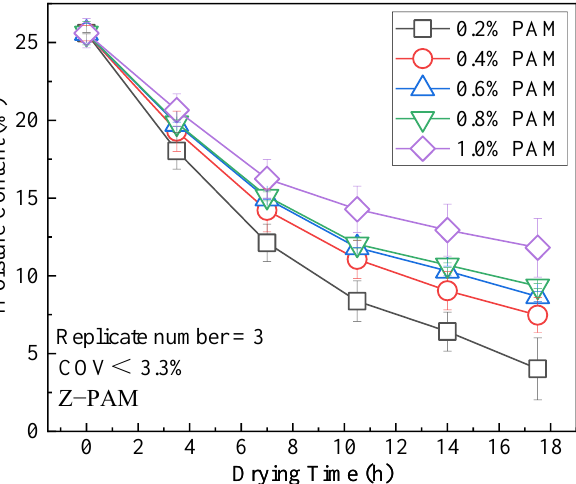
Figure 4. The moisture content of the compacted clay mixed with different PAM contents. Figure 5 reflects the influence of ZP content on the water loss of the compacted clay